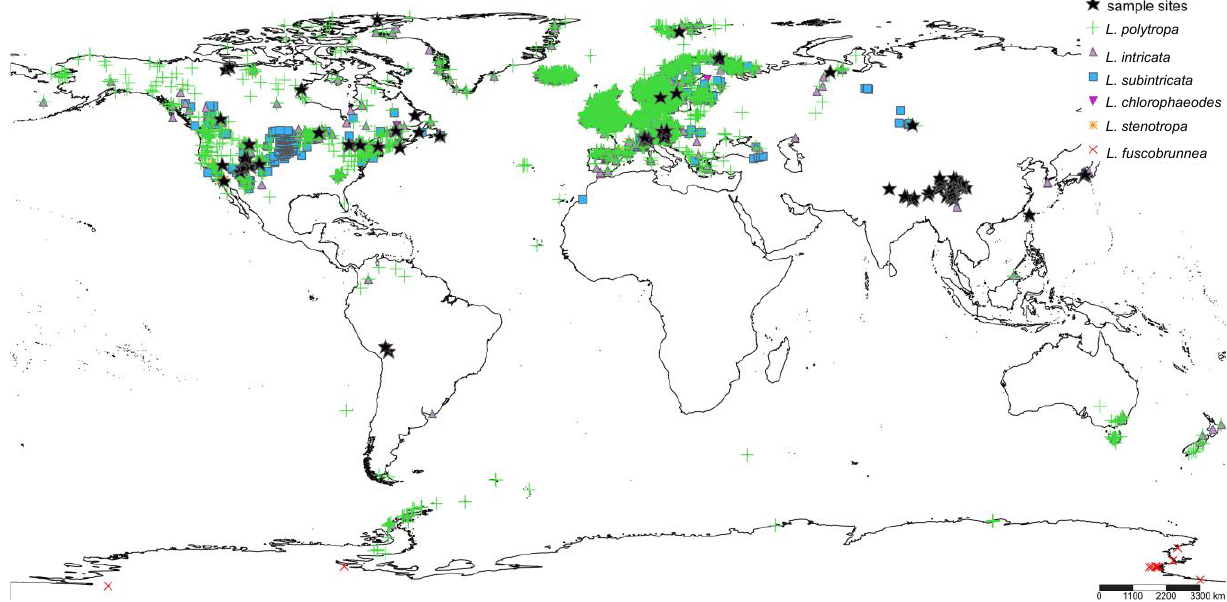
Figure 2. Geographic distribution of species within the Lecanora polytropa group based on records available from GBIF (https://www.gbif.org; accessed on 3 February 2022). Sampling sites are indicated with a ‘star’. The locations of specimens representing L. fuscobrunnea (Antarctic endemic, downloaded from GenBank) are not shown. The map was procuded using SimpleMappr (https://www.simplemappr.net; accessed on 3 February 2022).